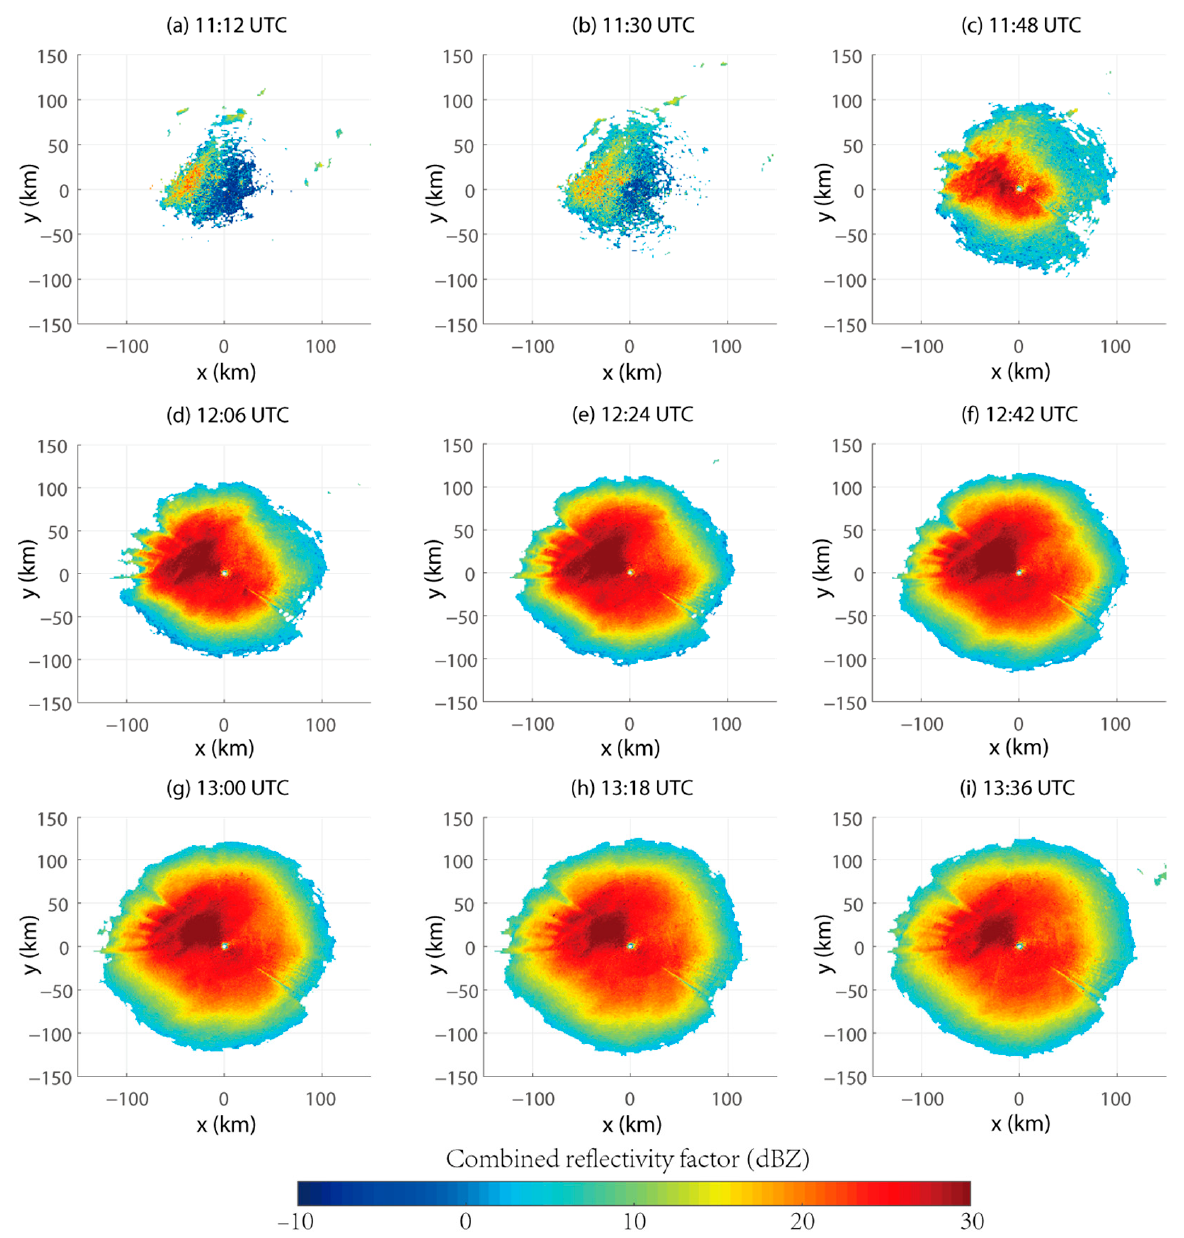
Figure 6. Combined reflectivity factor for 2.4 h from the CINRAD/SA, 2 May 2021. ( a – i ) Continuous observations from the CINRAD/SA at 12 min intervals from 11:12 to 13:36. The horizontal and vertical coordinates are, respectively, the ranges (km) in the west–east direction and the south–north direction.